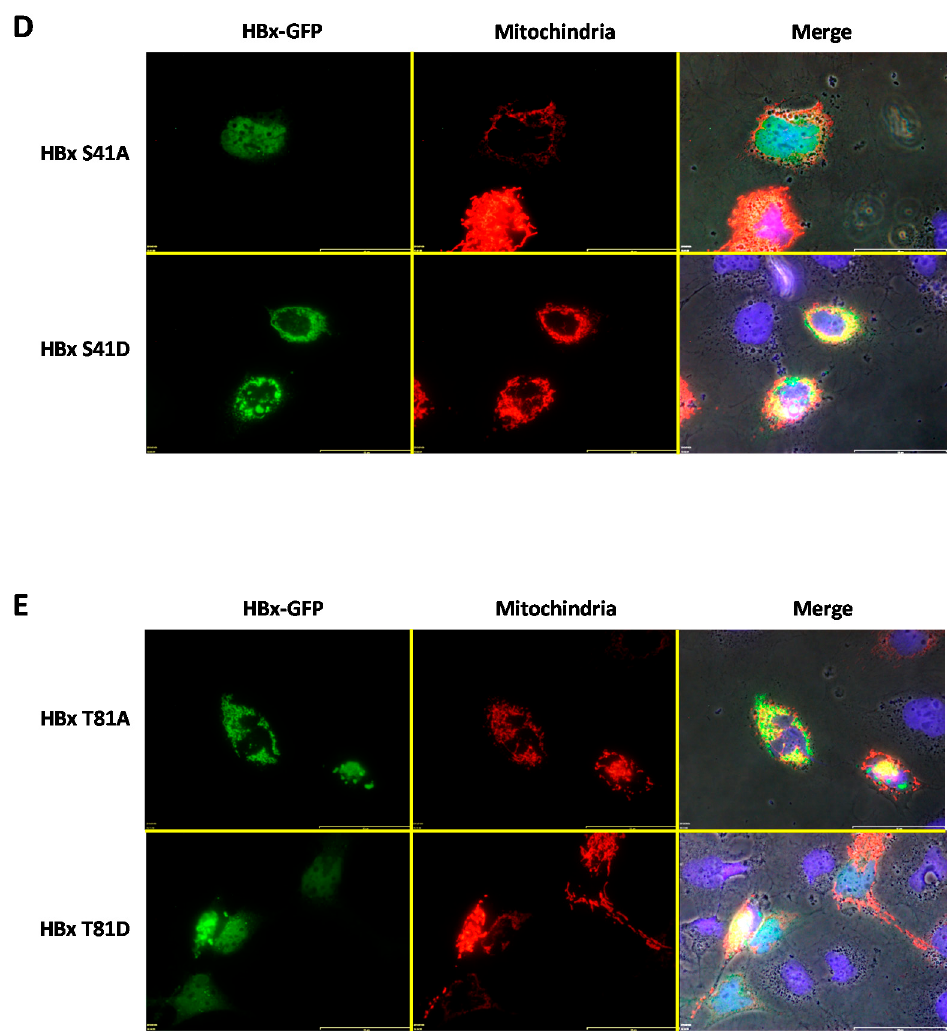
Figure 4. Fluorescence of the HBx-GFP protein and point mutants in cells co-transfected with DsRed2-Mito. ( A ) Fluorescence of hepatoma cells transfected with pDsRed2-Mito. ( B ) Fluorescence of hepatoma cells co-transfected with pDsRed2-Mito and WT HBx-GFP. ( C ) Fluorescence of hepatoma cells co-transfected with pDsRed2-Mito and either HBx S25A-GFP (upper panel) or HBx S25D-GFP (lower panel). ( D ) Fluorescence of hepatoma cells co-transfected with pDsRed2-Mito and either HBx S41A-GFP (upper panel) or HBx S41D-GFP (lower panel). ( E ) Fluorescence of hepatoma cells co-transfected with pDsRed2-Mito and either HBx T81A-GFP (upper panel) or HBx T81D-GFP. Bar for scale of 50 µm.